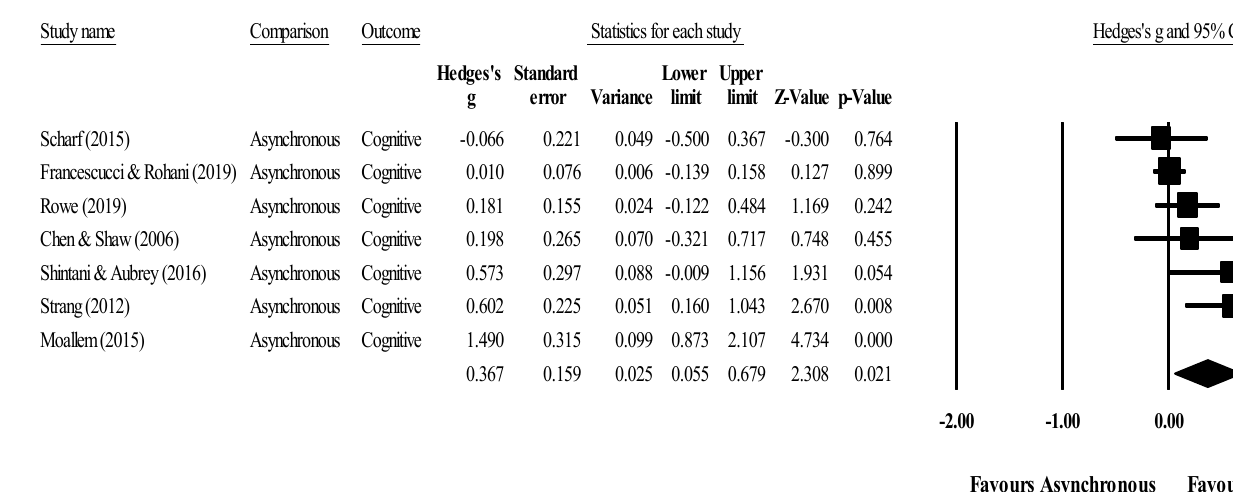
Forest Plot of Cognitive Outcomes (Synchronous vs.